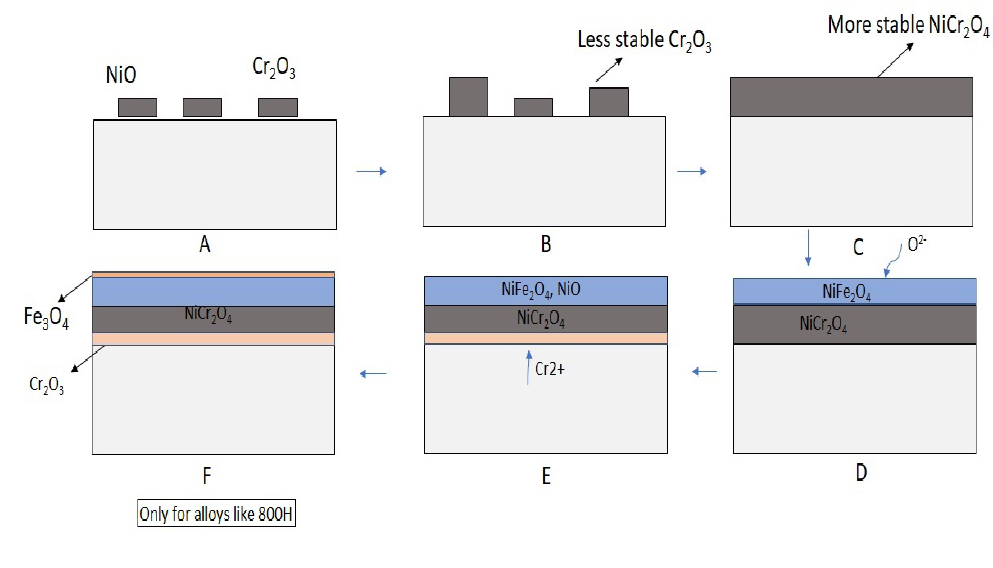
Figure 11. Oxide growth mechanism of IN 617